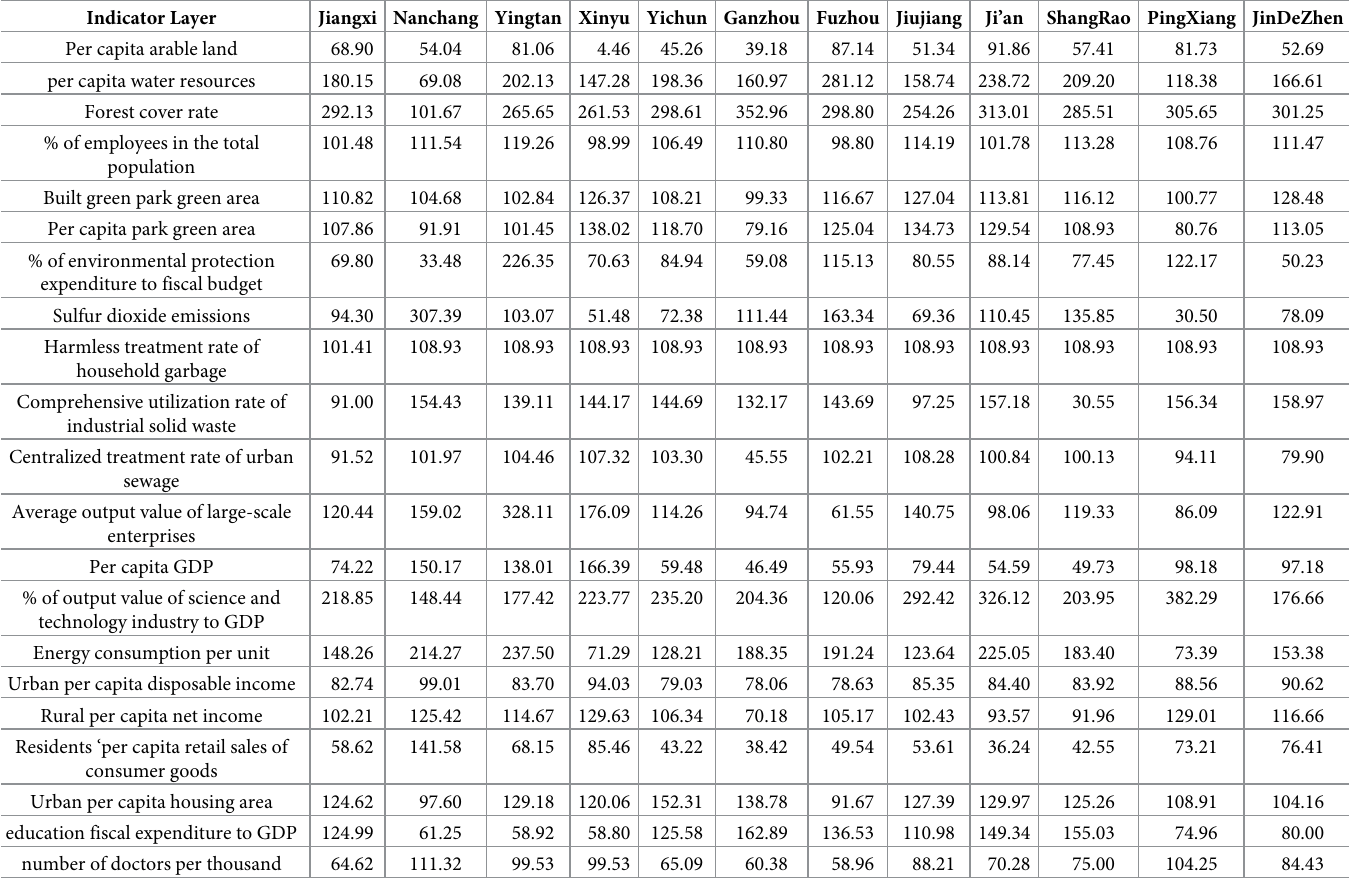
Table 2. Indicator values of ecological civilization of Jiangxi Province after dimensionless (2014). Indicator